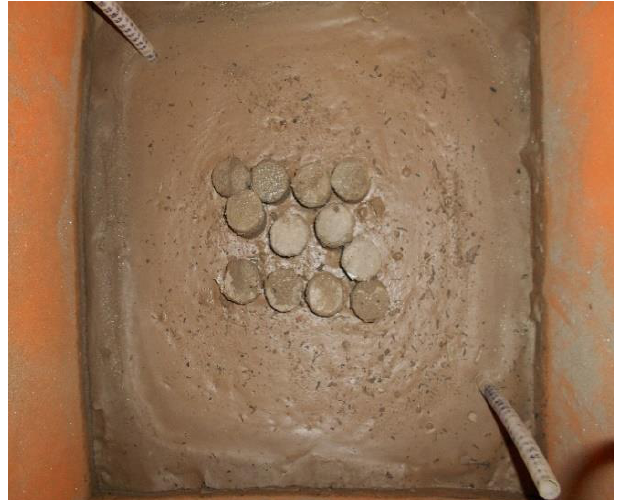
Fig. 12. Absolute intact columns after shaking